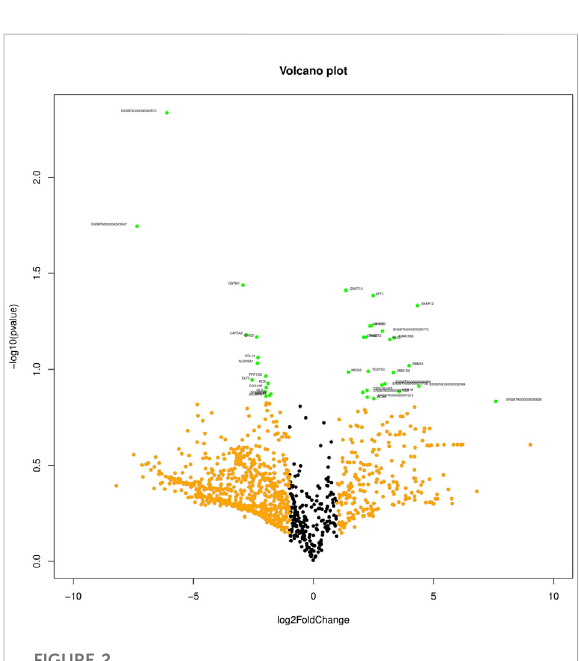
Volcano plot representing the gene log-fold changes and p -value. Green dots: signi fi cantly differentially expressed genes.